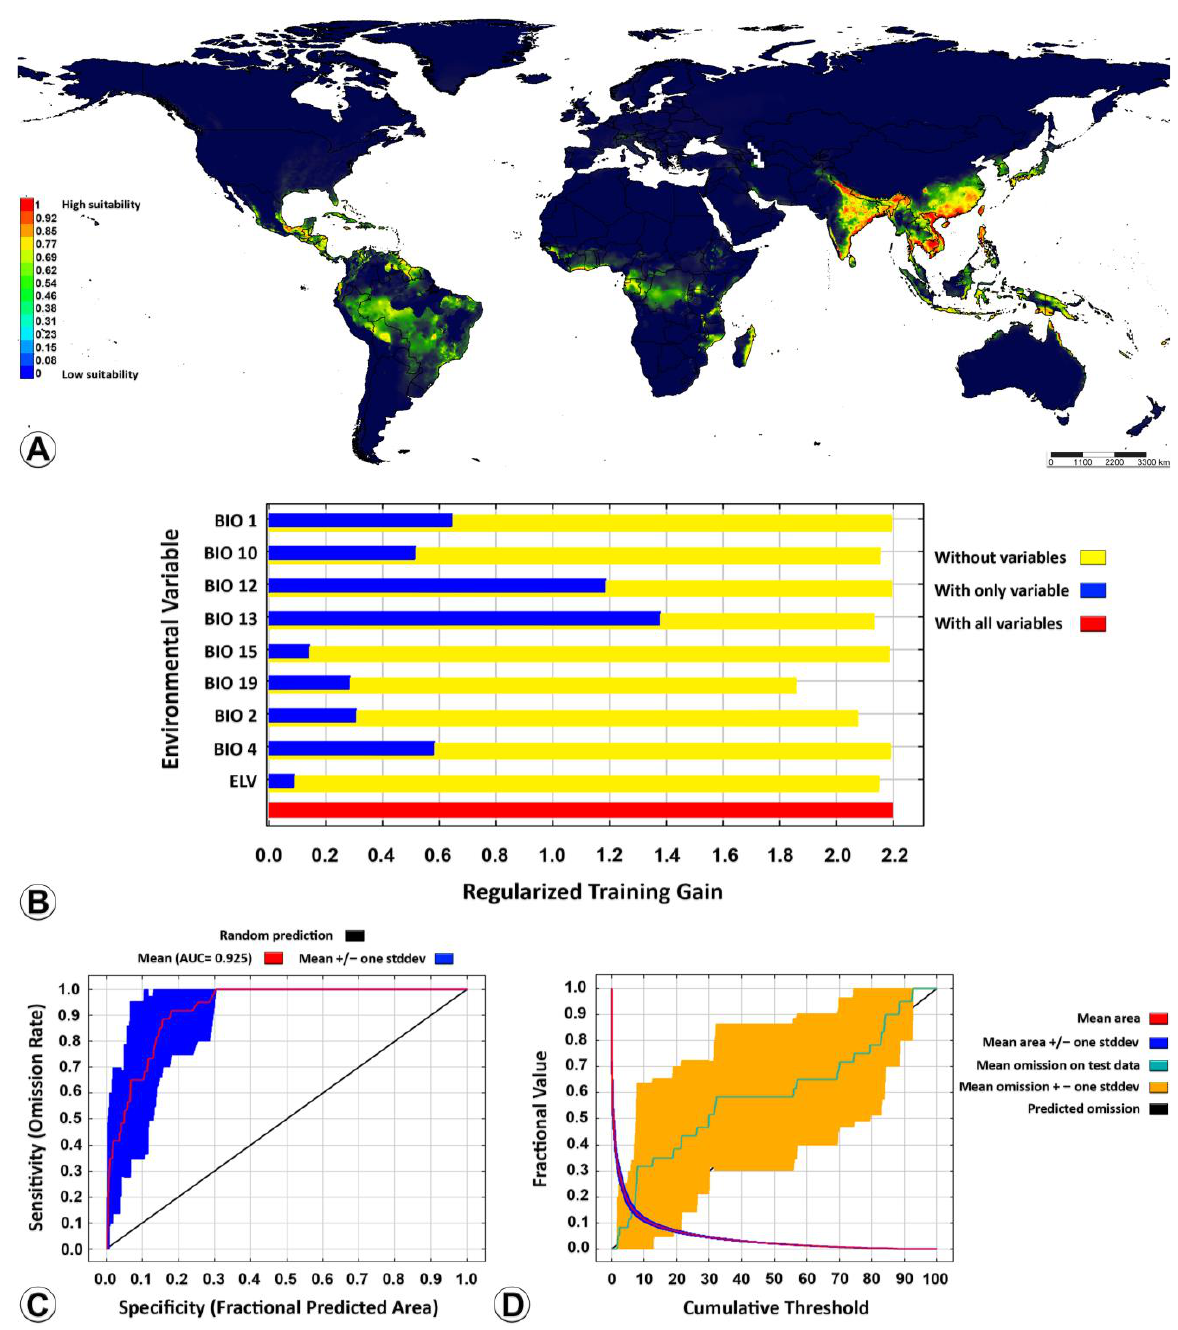
Figure 5. MaxEnt outputs of Microplitis manilae under its current distribution. ( A ) Current suitable distribution in a global context; ( B ) importance of bioclimatic variables to M. manilae by Jackknife test; ( C ) ROC curve of potential distribution prediction; ( D ) curve of omission and predicted area. High-suitability areas have a probability of 1 – 0.77; medium-suitability areas have a probability of 0.77 – 0.46; low-suitability areas have a probability of 0.46 – 0.23; unsuitable areas have a probability of 0.23 – 0. AUC = area under the curve; MaxEnt = maximum entropy modelling; ROC = receiver operating characteristic curve.